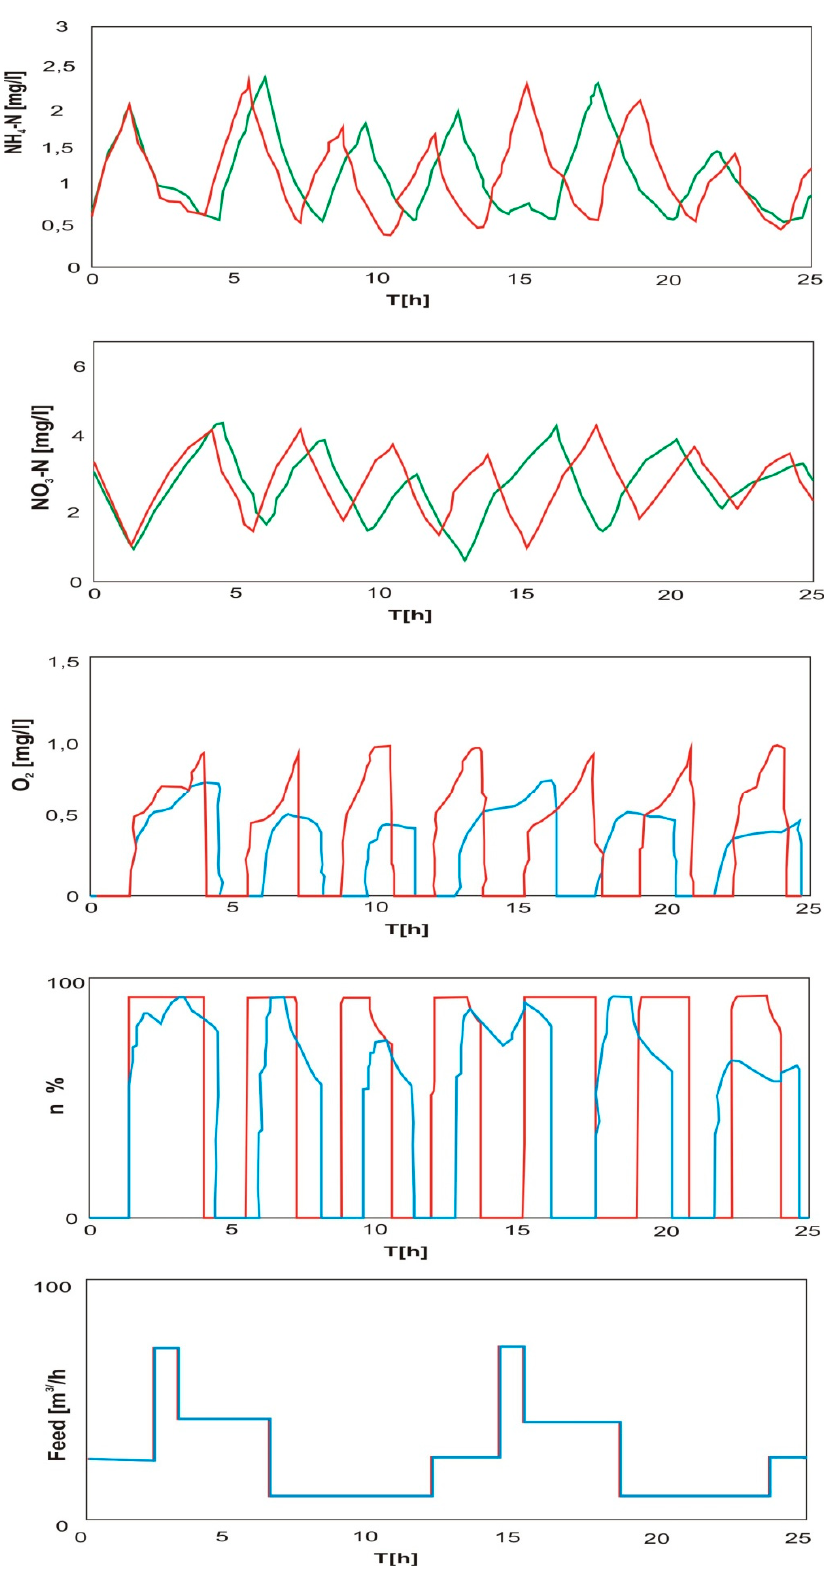
Figure 7. Simulation results for a variable raw sewage stream. The classic closed-loop control in red was marked in blue, using the MPC controller; (NH 4 ) ammonia concentration, (NO 3 ) nitrate concentration, (O 2 ) dissolved oxygen concentration in nitrifying chambers, (n) blower speed, influent flow rate (feed) [own elaboration].